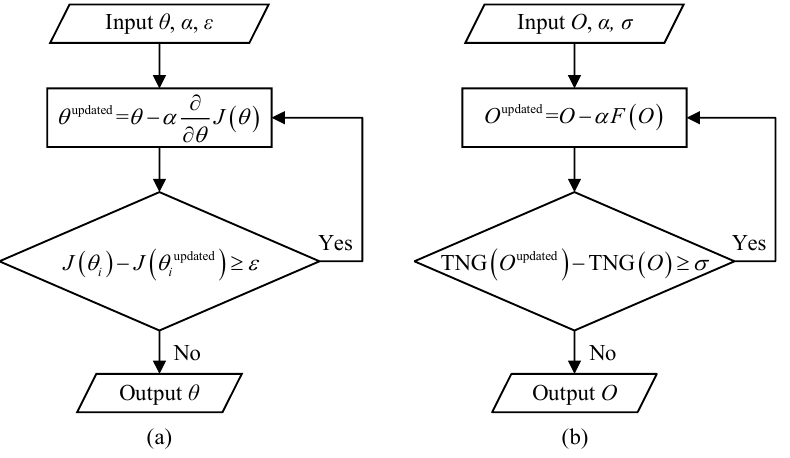
Figure 1. Algorithm flow chart. ( a ) Flow chart of the gradient descent idea. ( b ) Flow chart of our gradient-descent-like ghost imaging